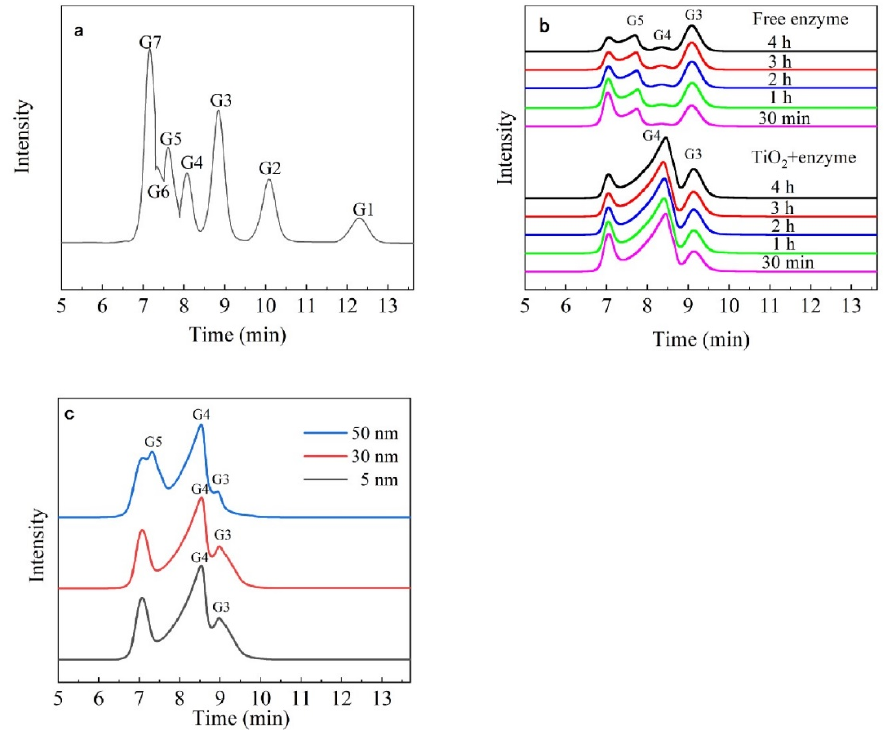
Figure 6. ( a ) Standard oligosaccharides G1–G7: glucose, isomaltose, isomaltotriose, isomaltotetraose, isomaltopentaose, isomaltohexose, and isomaltoheptaose ( b ) free enzyme and immobilized dextranase enzymatic products at different reaction times, ( c ) analysis of the 1 h digestion products of 5 nm, 30 nm, and 50 nm TiO 2 -immobilized dextranase.